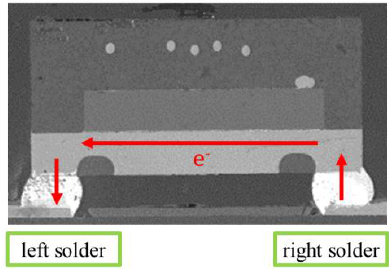
Figure 2. Electron flow direction (opposite current direction) during the EM test.